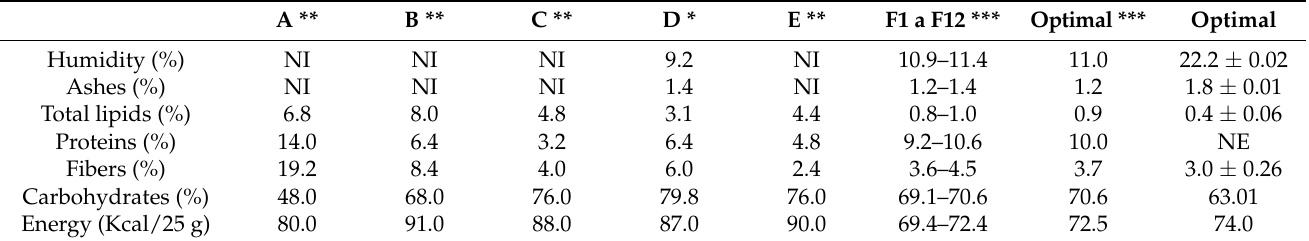
Table 6. Physicochemical composition of optimal cereal bars in comparison to commercialized samples.